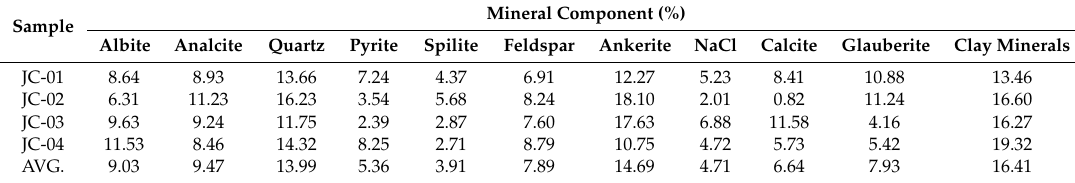
Table 4. Mineral composition of interlayer determined by XRD.